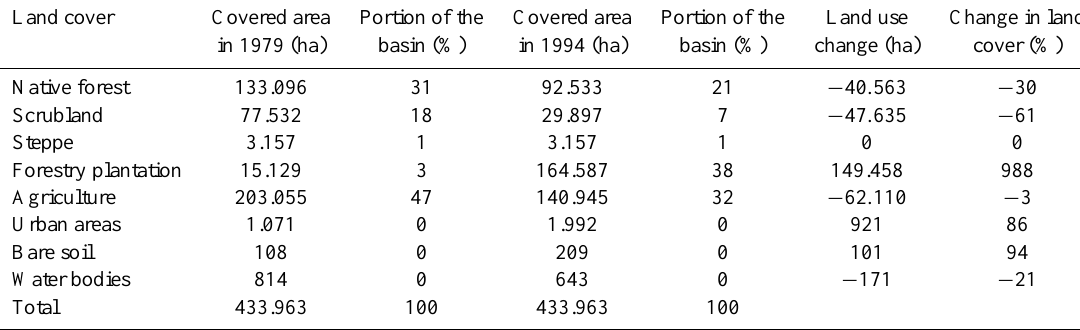
Table 2. Changes in land cover between 1979 and 1994.